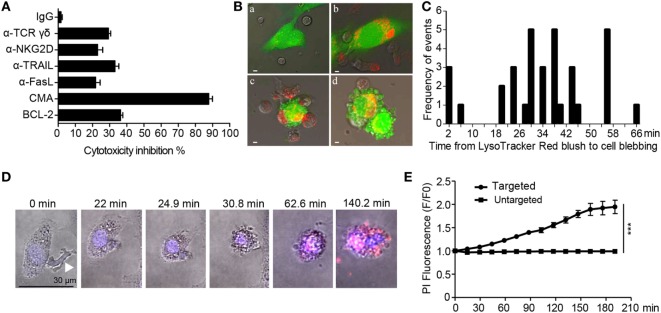
The cytolytic process is largely dependent on the perforin/granzyme B pathway. (A) Specific lysis of LX-2 cells (pretreated with 5 µM BPH-1236) by expanded Vγ9Vδ2 T cells in the presence of neutralization antibodies or inhibitors: anti-NKG2D (α-NKG2D), anti-FasL (α-FasL), anti-TRAIL (α-TRAIL), anti-TCR γδ (α-TCR γδ), the perforin inhibitor Concanamycin A (CMA), granzyme B inhibitor (BCL-2). Data are presented as mean ± SEM of three replicates from a representative experiment of three independent experiments. (B) Confocal microscopy of the co-culture of LX-2 cells (5(6)-carboxyfluorescein N-hydroxysuccinimidyl ester (CFSE) labeled, green, pretreated with 5 µM BPH-1236 for 4 h) and Vγ9Vδ2 T cells (labeled with LysoTracker Red). a, Vγ9Vδ2 T cells were seeded along with BPH-1236 pretreated LX-2 cell cultures; b, Vγ9Vδ2 T cells moved toward the LX-2 cells, and released perforin/granzyme lytic granules through the immunological synapse into LX-2 cells; c, the target LX-2 cell lost its initial shape and started to acquire a round morphology; d, LX-2 cells broke up into many membrane-bound bodies, with apoptosis. Scale bar, 5 µm. (C) Frequency distribution of the times (minutes) between the LysoTracker Red blush to the first sign of cell blebbing. Columns represent 2-min time intervals (n = 34 apoptotic target cell deaths). (D) Time-lapse microscopy of Vγ9Vδ2 T cells and BPH-1236 pretreated LX-2 cells in the presence of PI and Hoechst 33258. Images were acquired about every 88 s and show the Hoechst 33258 (blue)/PI (red)/Brightfield overlay. White arrow indicates the Vγ9Vδ2 T cell. Images depict cytosolic diffusion of PI into the target LX-2 cells from the point of Vγ9Vδ2 T cell contact with LX-2 cell (0 min), followed by cell rounding, membrane blebbing, and late stage of PI dispersion. Scale bar, 30 µm. Images are representatives of 14 target cells. (E) Monitoring the PI fluorescence change over time in targeted (Vγ9Vδ2 T cell hit LX-2 cells) and untargeted (non-hit LX-2 cells). Images were acquired every 88 s. Data represent the mean ± SEM for fold change (F/F0) in PI fluorescence over time (n = 14 Vγ9Vδ2 T cell hit LX-2 cells and n = 12 non-hit LX-2 cells). ***P < 0.001.